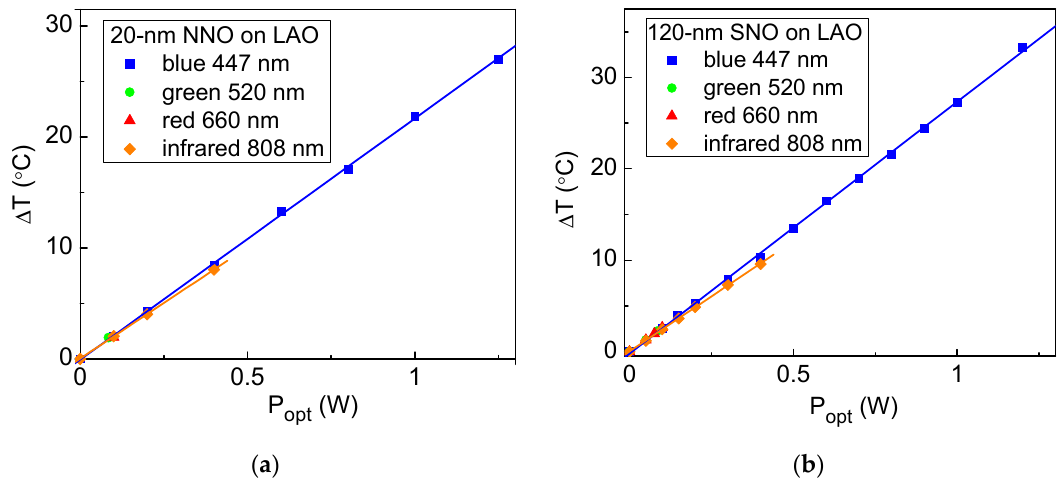
Figure A6. Estimated temperature increments as functions of the optical power for all light wavelengths with the corre- sponding linear fits for ( a ) the 20-nm thick NNO and ( b ) the 120-nm thick SNO films on LAO. Table values of the heat capacity and the density (0.57 and 0.733 J/g·K as well as 6.74 and 2.65 g/cm 3 for LSAT and quartz, respectively) are taken to estimate a heating of the isolated substrates of 3.2 × 10 mm size in the main text. References 1.